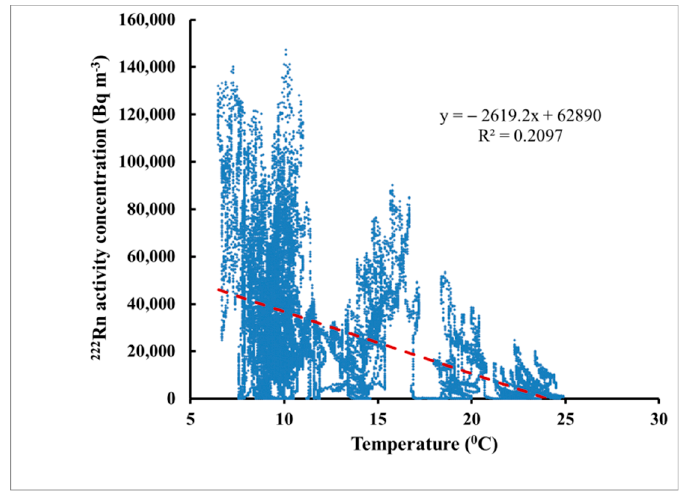
Figure 3. The correlation between the temperature and the 222 Rn activity concentration. The statistical analysis made by PAST statistical package [7] showed a statistically significant (at 95% level of confidence) negative correlation.